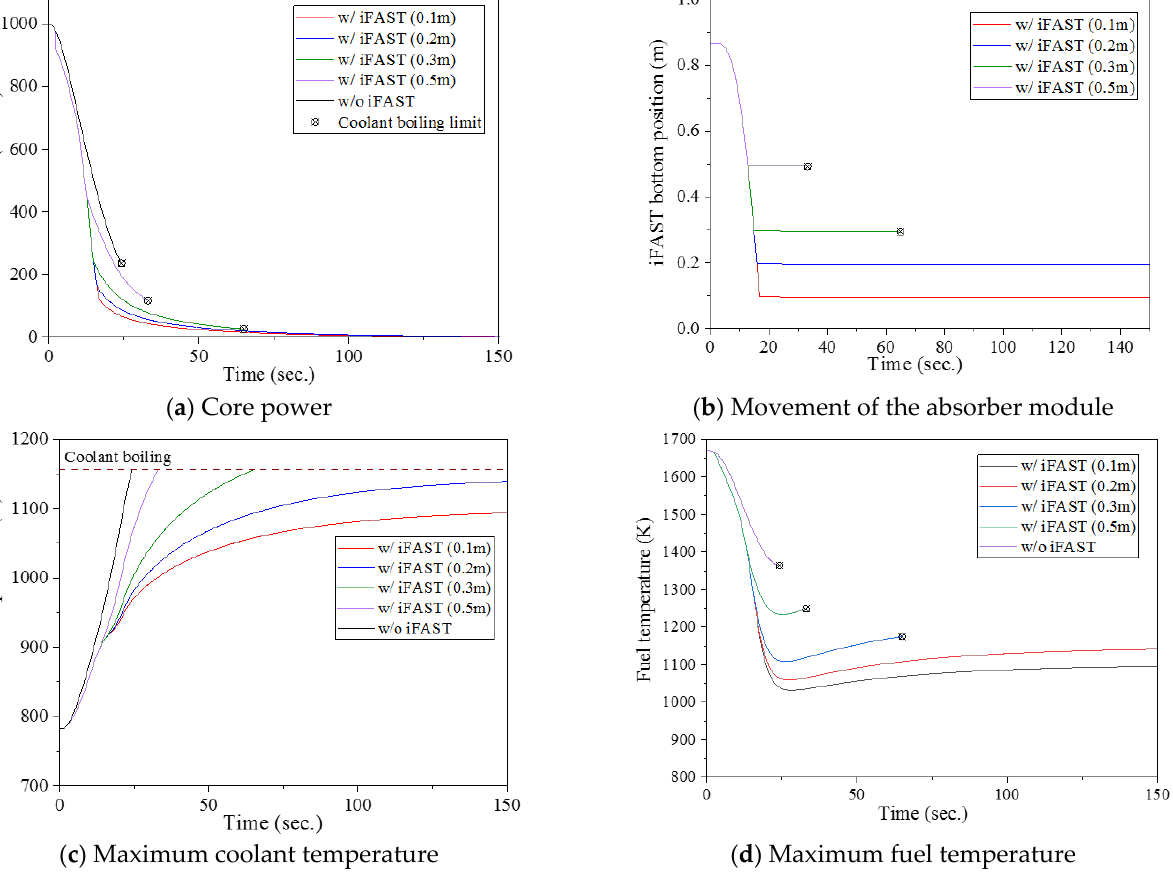
Figure 12. Unprotected loss of heat sink in ABR reactor and 1.8$ maximum iFAST worth